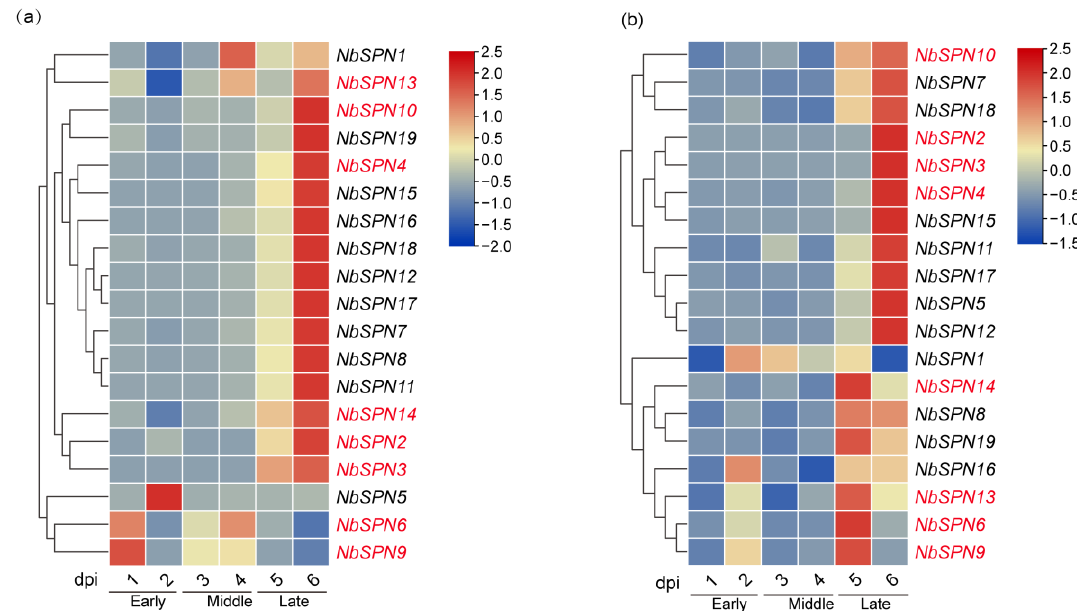
Figure 9. N. bombycis serpins ’ transcription patterns of the midgut and the fat body in infected silk- worms. They are divided into the early, middle, and late stages along with the time of infection. The predicted genes that could encode signal peptides are marked in red. ( a ) Transcriptional expression patterns of different serpin genes are in the infected midgut. ( b ) Transcriptional expression patterns of varying serpin genes are in the infected fat body.